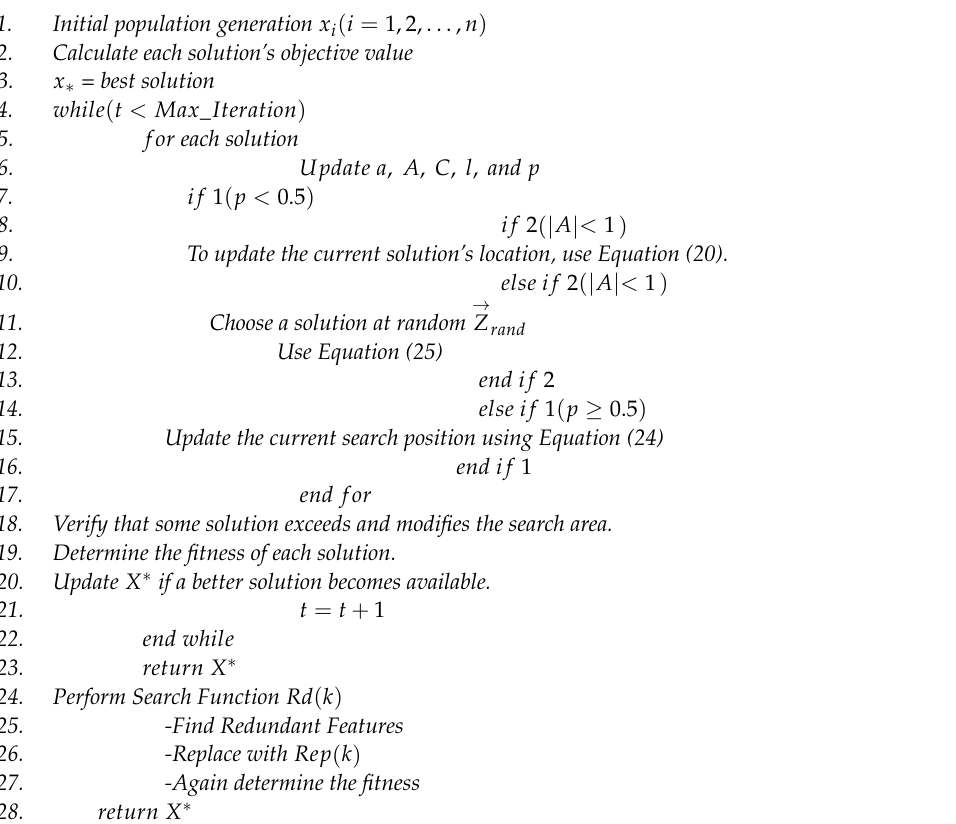
Algorithm 1 Modified Whale Optimization for Best Features